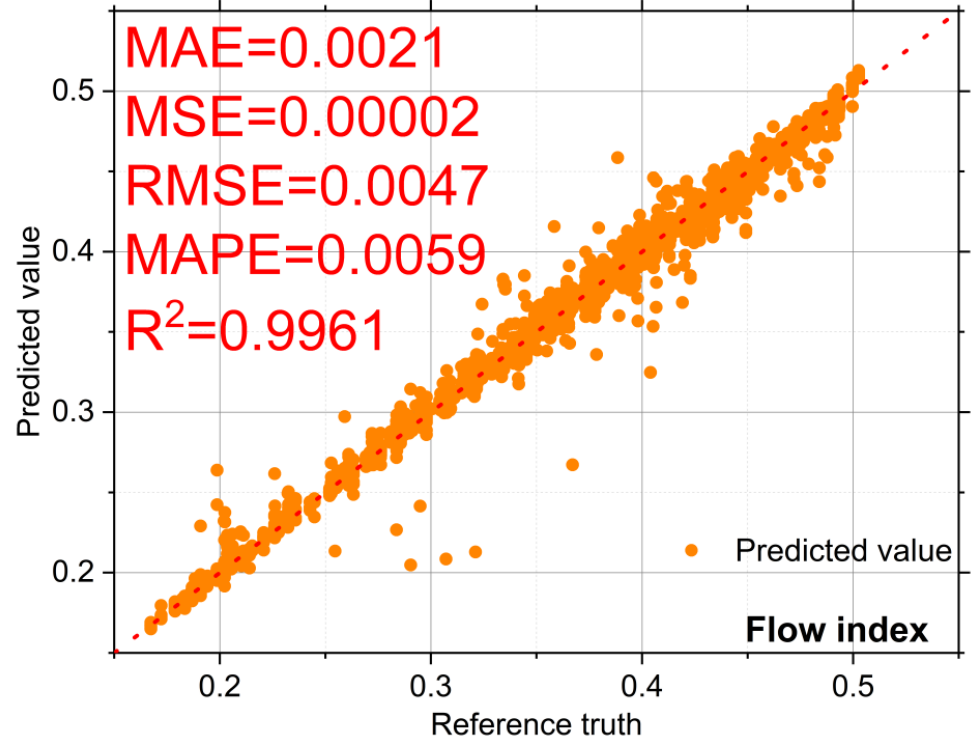
Figure 14. Accuracy of emitter flow index prediction model based on the extended dataset.